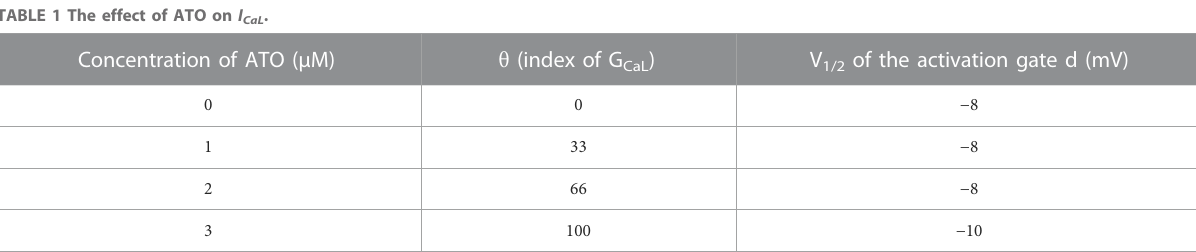
TABLE 1 The effect of ATO on I CaL . Concentration of ATO ( μ